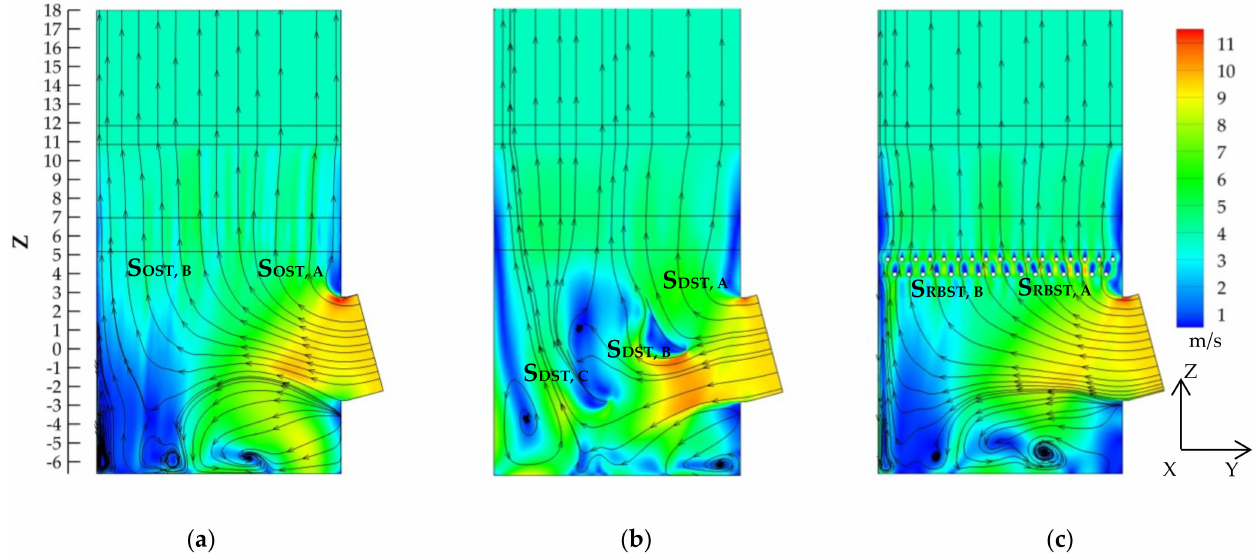
Figure 6. Velocity distribution: ( a ) OST; ( b ) DST; ( c ) RBST. In the OST, the gas velocity is high and the liquid concentration is low in the inlet